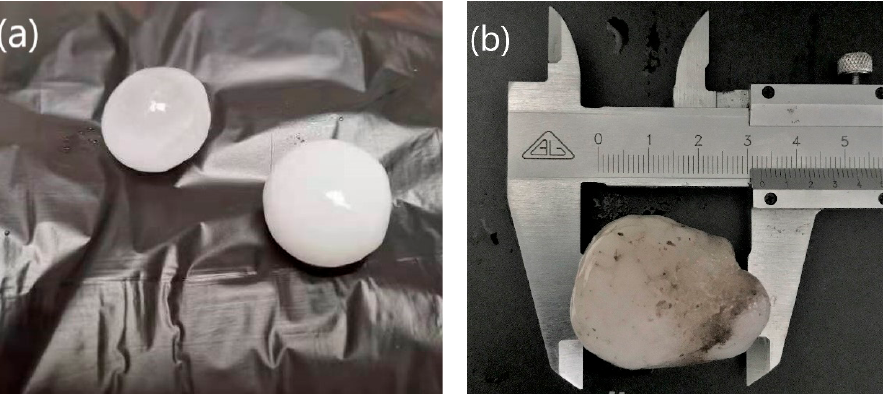
Figure 5. Hail samples taken at YanQing observation station. ( a ) Hail samples from 25 June 2021; ( b ) hail samples and measurements from 30 June 2021.